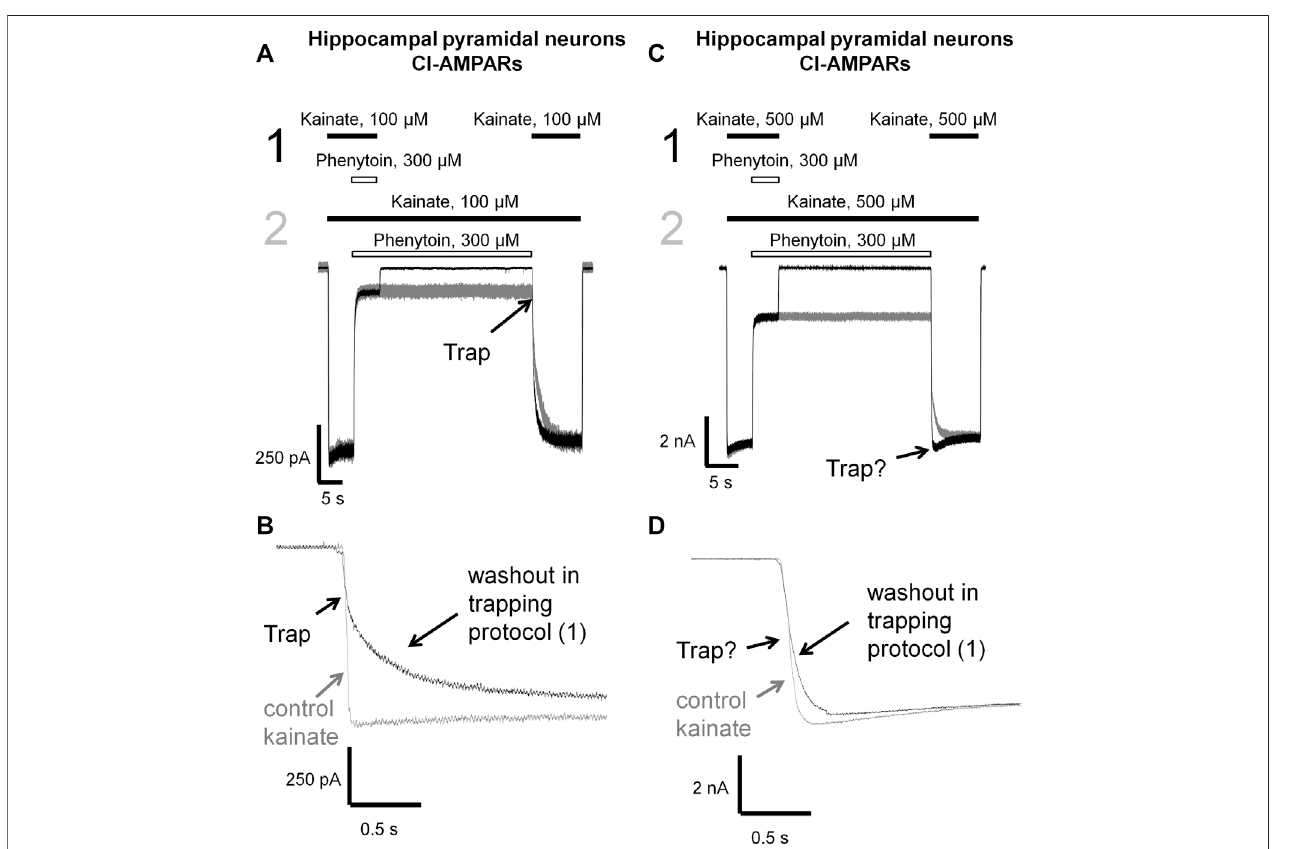
FIGURE 7 | Trapping of phenytoin in AMPAR channels. (A,C) Representative examples of phenytoin trapping in case of CI-AMPAR activation by 100 (A) and 500 µM (C) kainate in the double-pulse protocol (black traces) and recovery kinetics in the protocol without pause in extracellular solution (gray traces). Phenytoin of 300 µM demonstrated pronounced trapping at 100 µM kainate (A) , but trapping was questionable at 500 µM kainate (C) . (B,D) Superimpositions of rising fronts in control kainate application and testing kainate application in the double-pulse protocol in case of CI-AMPAR activation by 100 (B) and 500 µM (D) kainate.